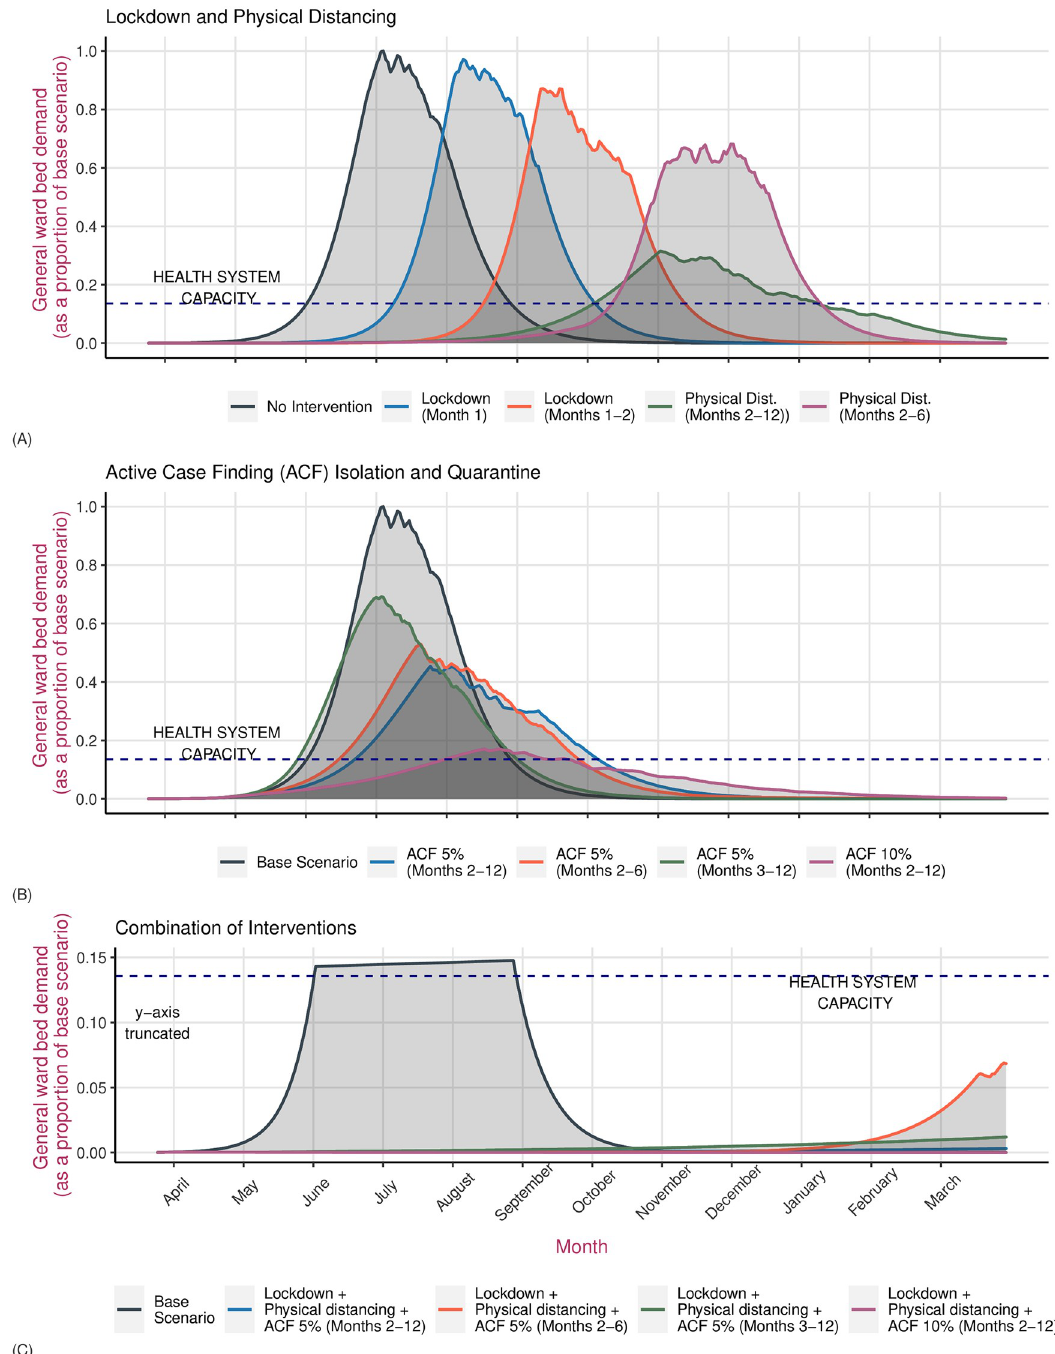
Fig 4. A comparison of the effectiveness of interventions against COVID-19 in reducing the demand for hospital beds. Panel (A) on the top compares lockdown or physical distancing measures implemented for a variable duration as compared to the base scenario of no intervention. Panel (B) in the middle compares active case finding measures with the base scenario. Panel (C) at the bottom compares the effectiveness of a combination of interventions with the base scenario. The blue line represents the health system capacity which is a total of 5400 hospital beds for Kathmandu, including approximately 250 ICU beds. The y-axis has been truncated in Panel (C) to accommodate observations that are closer to the x-axis.